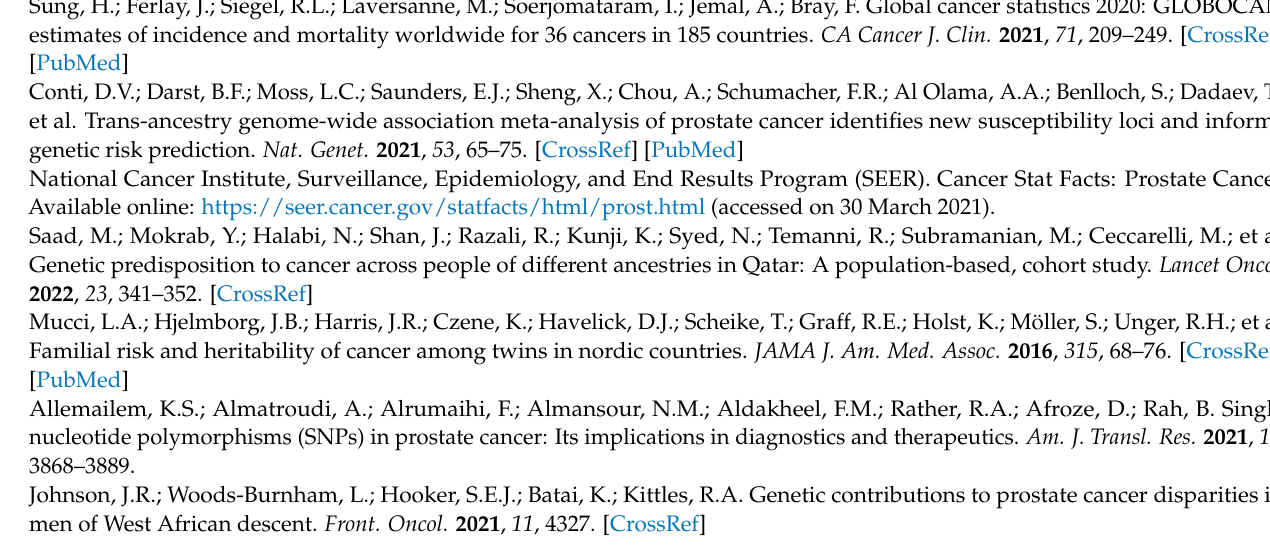
Table S3: SNPs correlated with PCa mortality and incidence in different